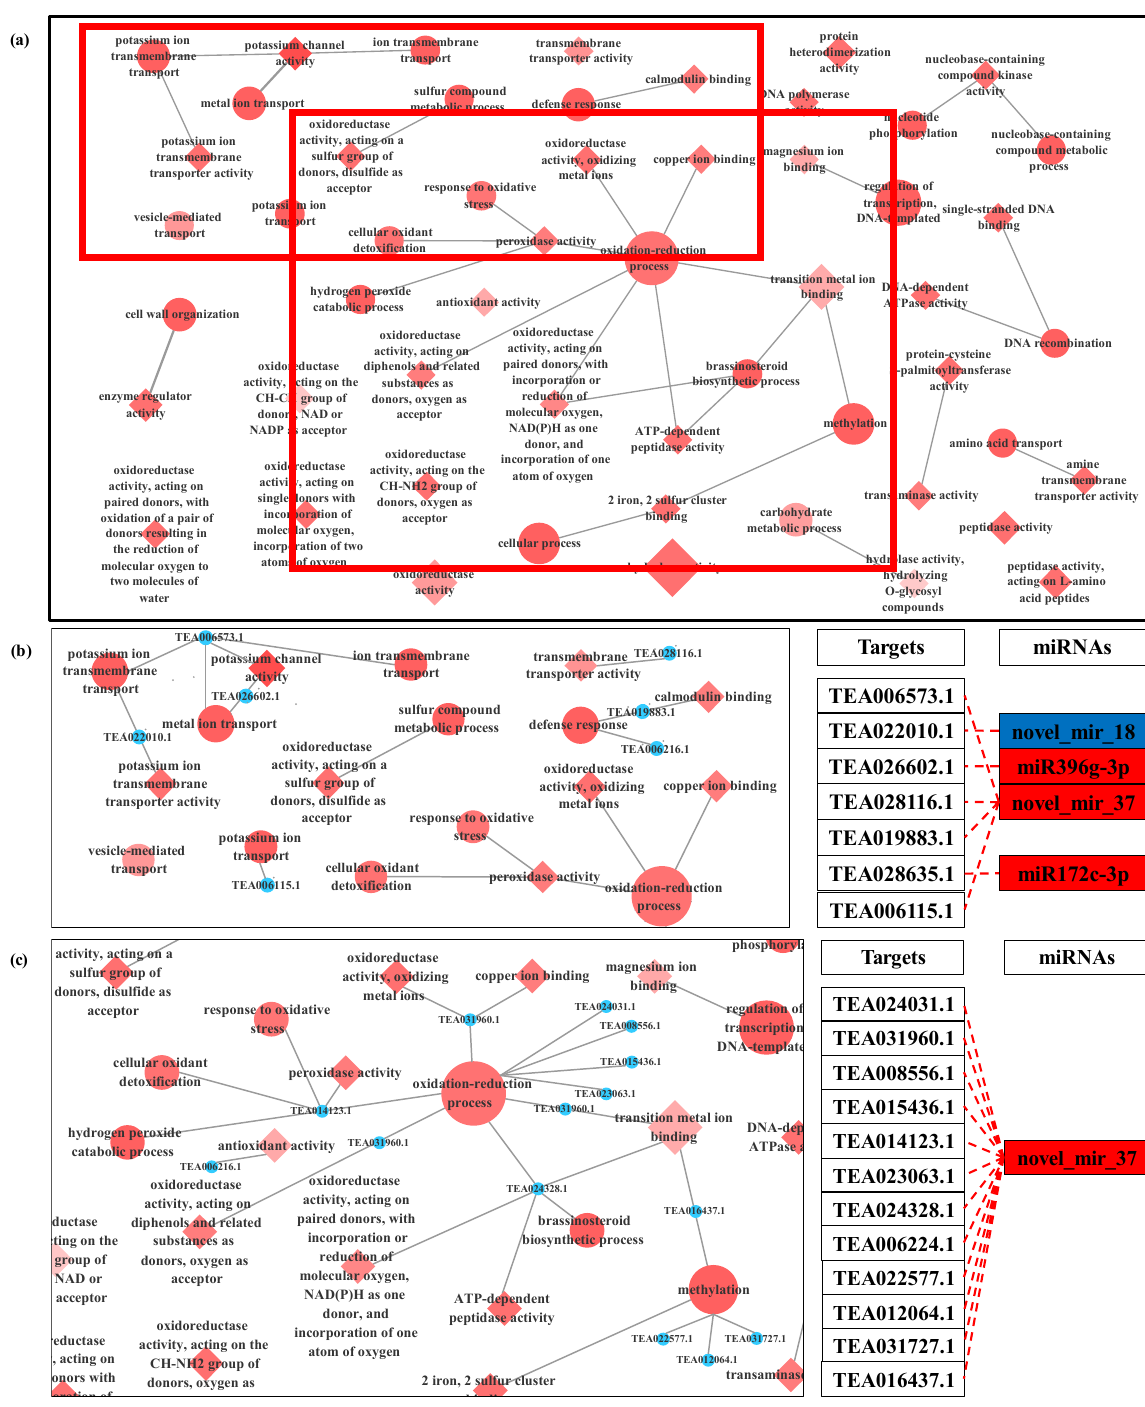
Figure 5. GO-GO network of the targeted genes of DEMs between NO (nitric oxide) and CK (control) ( a ). Local amplification of GO-GO network related to metal ion transport and its miRNA target ( b ). Local amplification of GO-GO network related to oxidation-reduction process and its miRNA target ( c ). In the network, circle represents the biological process term, and the diamond represents the molecular function term. The filling color of the GO term from white to red represents the enrichment degree (p.adjust) of the GO term. The color of the miRNA term indicates its regulation mode; red represents that miRNA is up-regulated in NO, and blue represents that miRNA is down-regulated in NO.